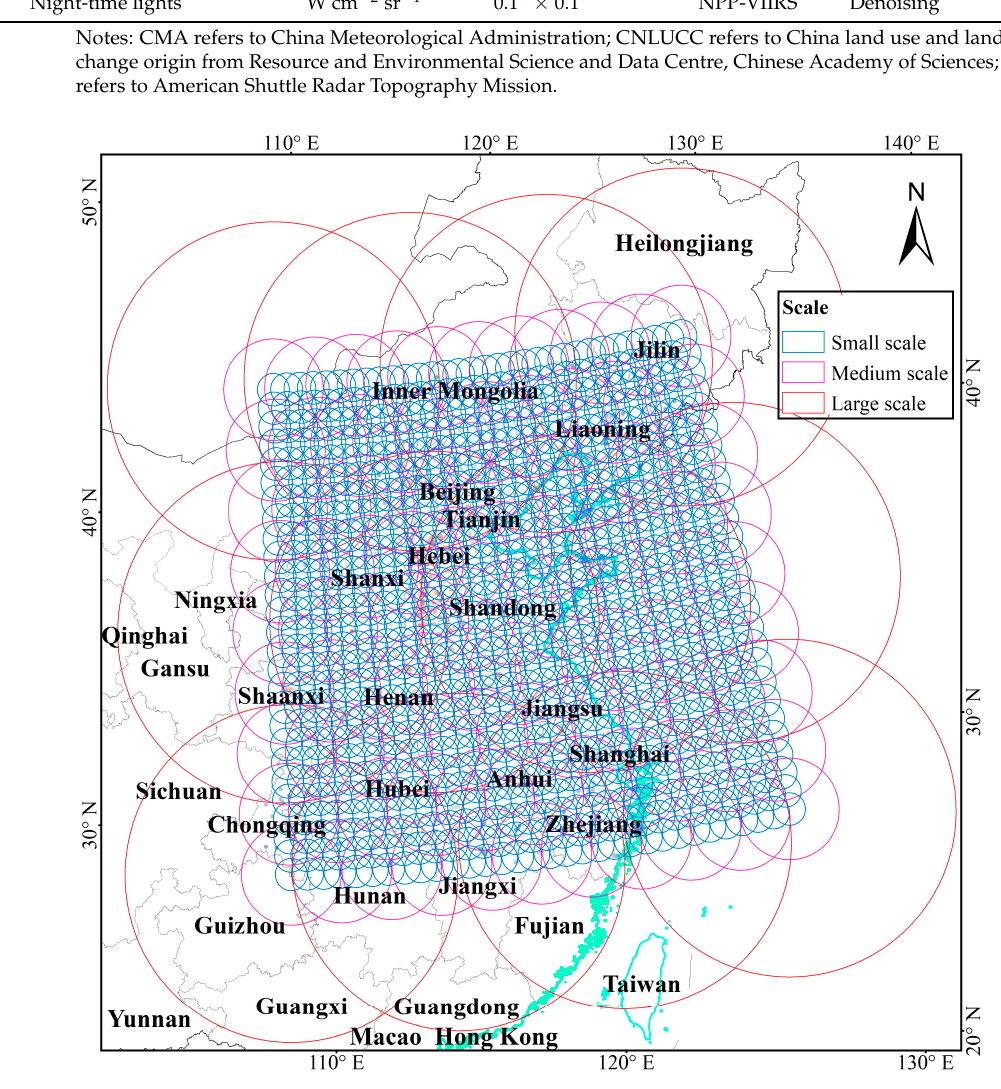
Figure 7. The scope of Gaussian spatial basis functions with three